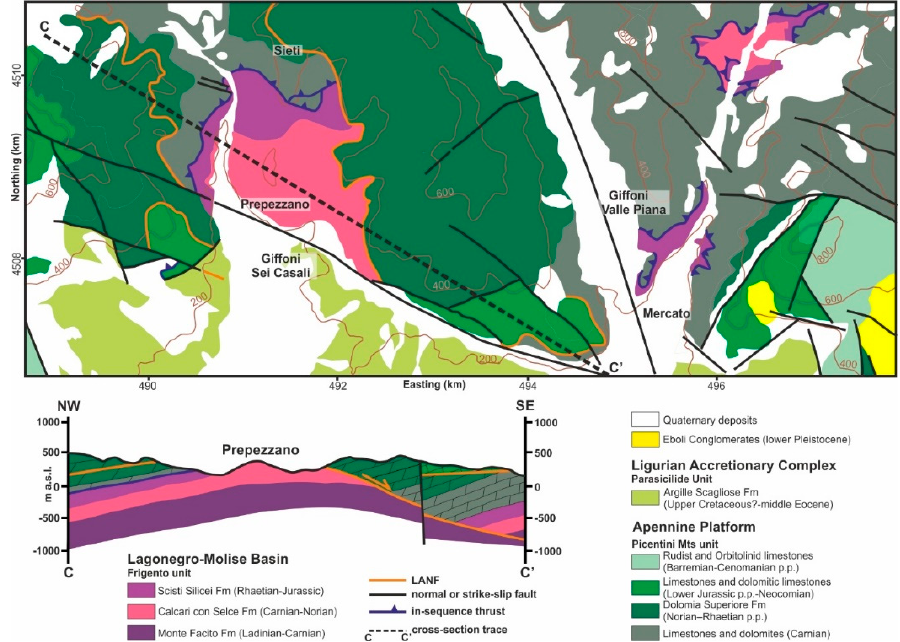
Figure 4. Geological map of the Giffoni tectonic window (modified after [23]). WGS84-F33N Projection.